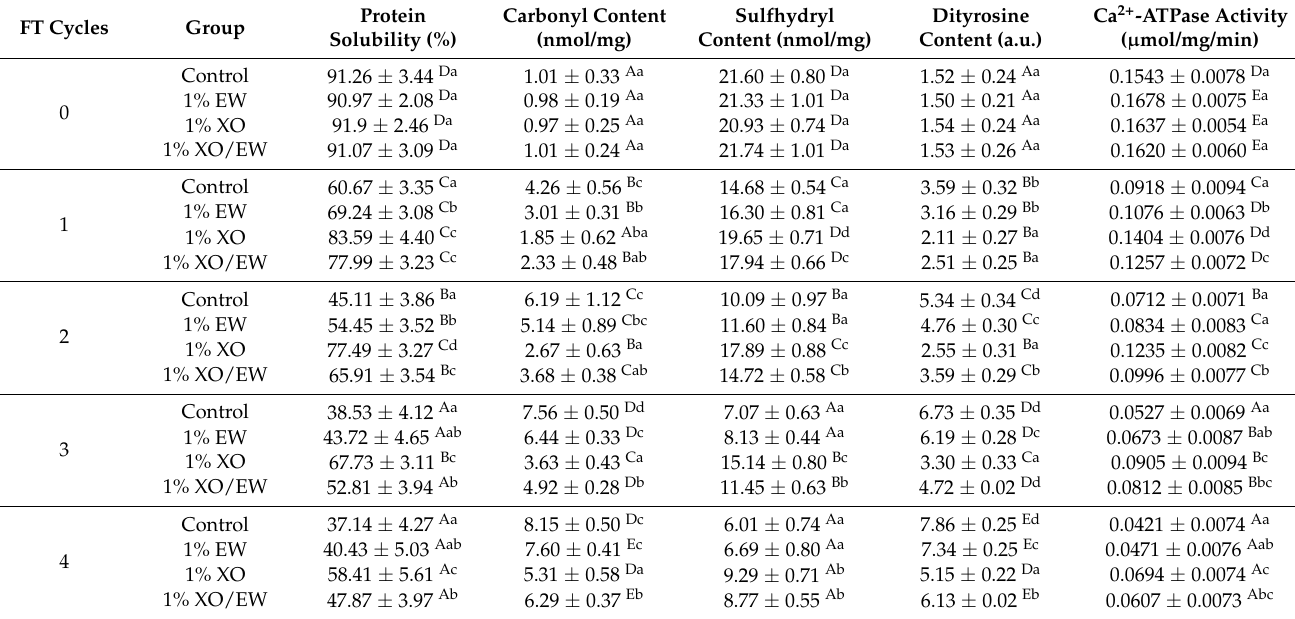
Note: The control group (Control) was not added with EW, XO, or XO/EW. Capital letters indicate a significant difference ( p < 0.05) between different freeze–thaw cycles within the same treatment group. Lowercase letters indicate a significant difference ( p < 0.05) between different treatment groups in the same freeze-thaw